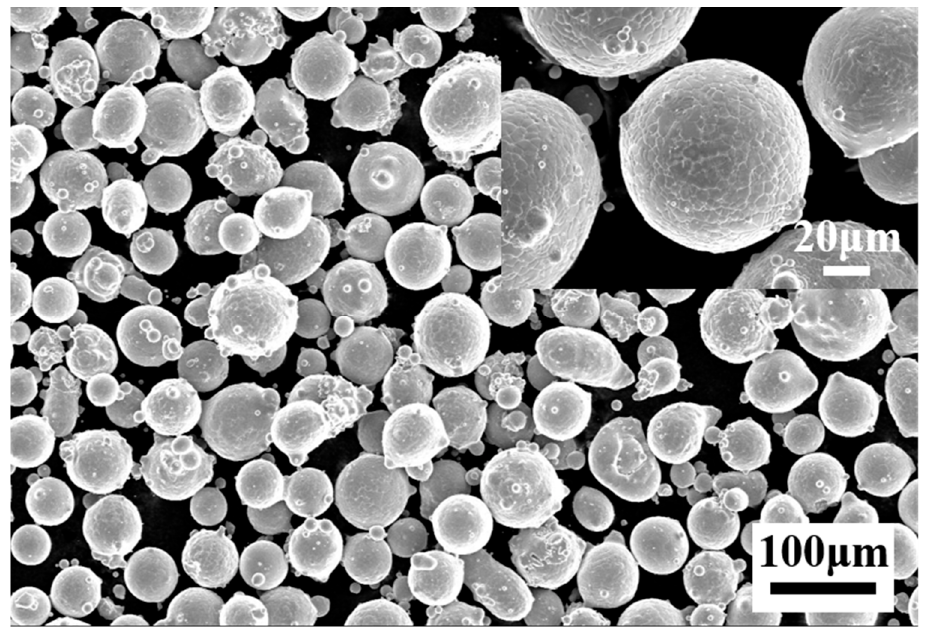
Figure 1. SEM morphology of Inconel 690 powder for LMD, with the upper inset showing micro- dendritic microstructure.